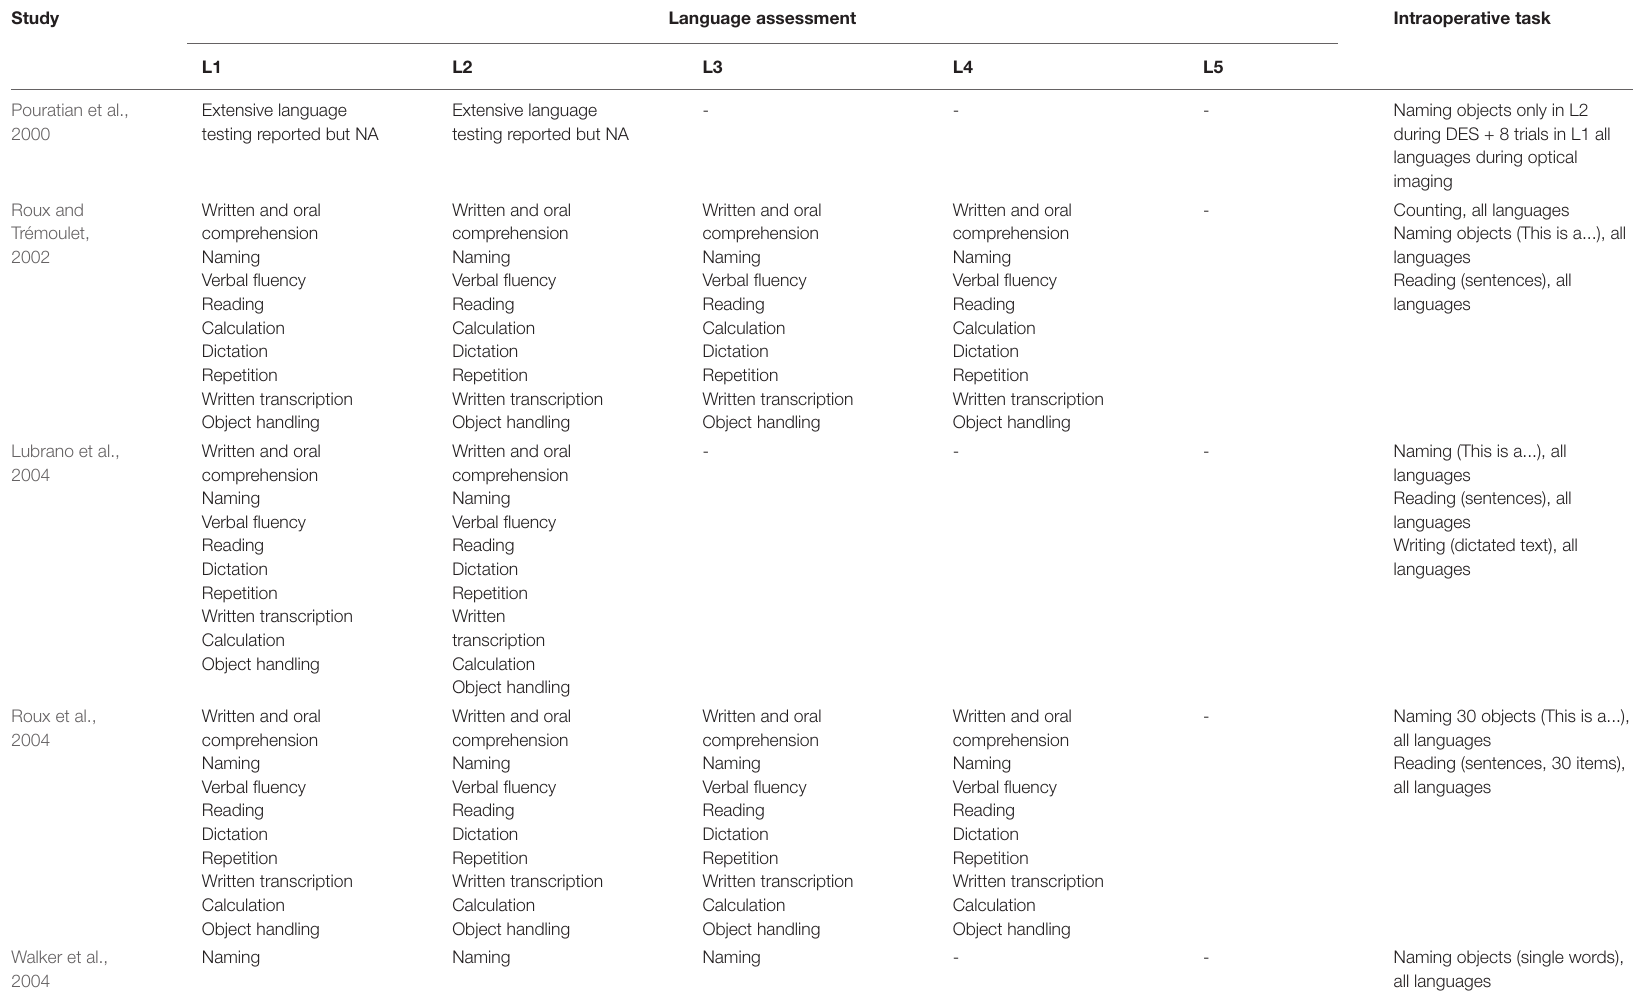
TABLE 5 | Language assessment and Intraoperative tasks.